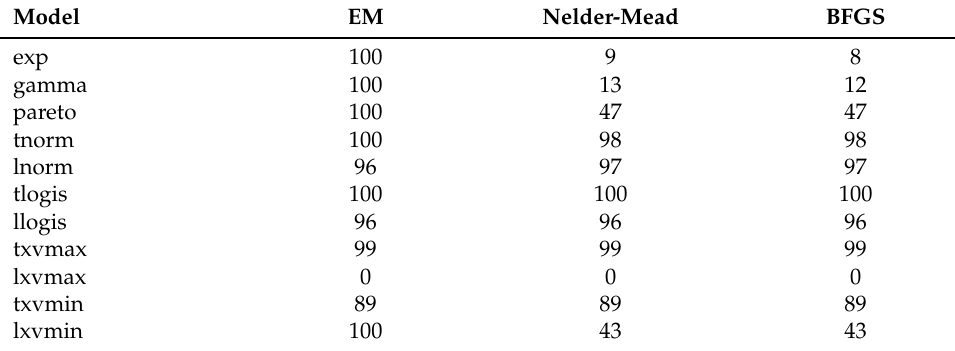
Table 4. The number of converged estimations